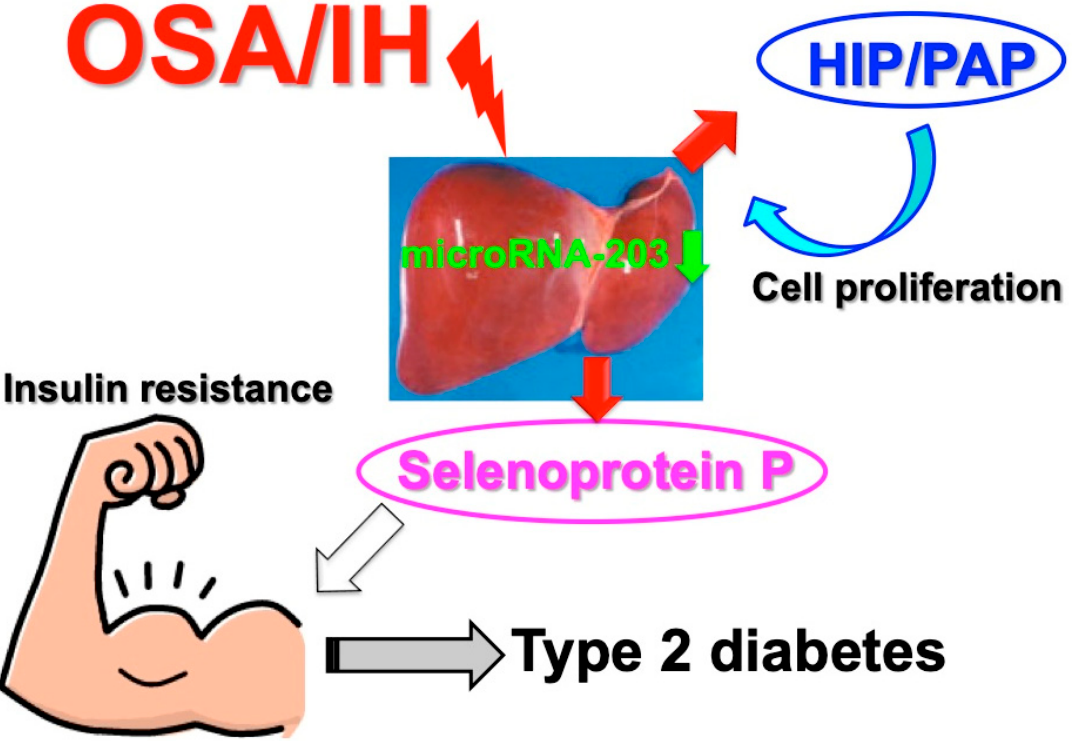
Figure 4. A possible mechanism of IH-induced insulin resistance by selenoprotein P. IH stress downregulates microRNA-203 in hepatocytes. The mRNAs for selenoprotein P and HIP/PAP target microRNA-203. As a result, IH exposure upregulates hepatokine(s) such as selenoprotein P to increase insulin resistance, as well as HIP/PAP to increase hepatocyte proliferation [50].